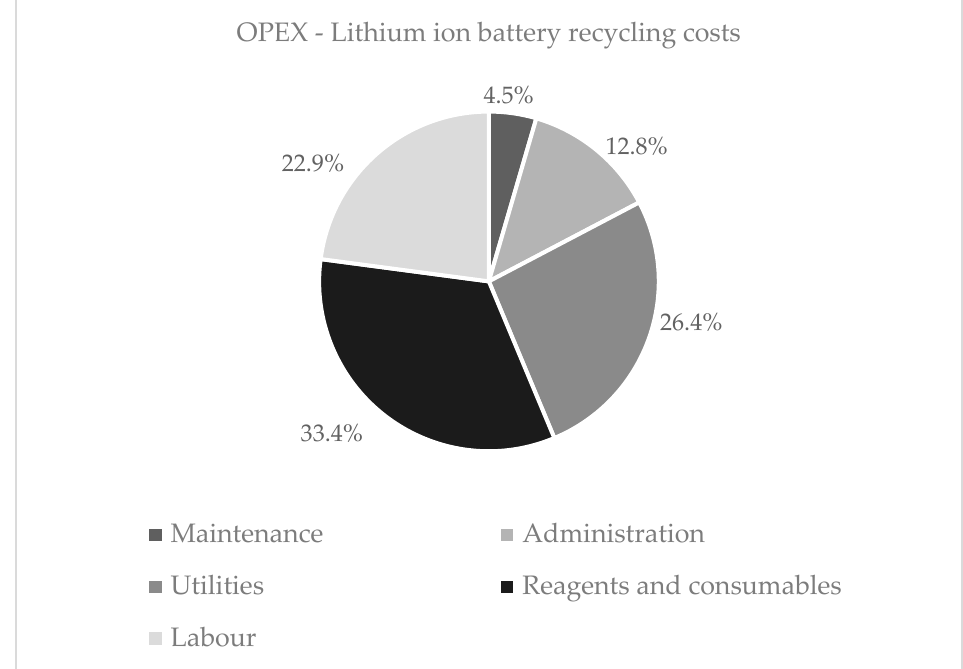
Figure 8. OPEX lithium-ion battery recycling costs. Adapted from [39].